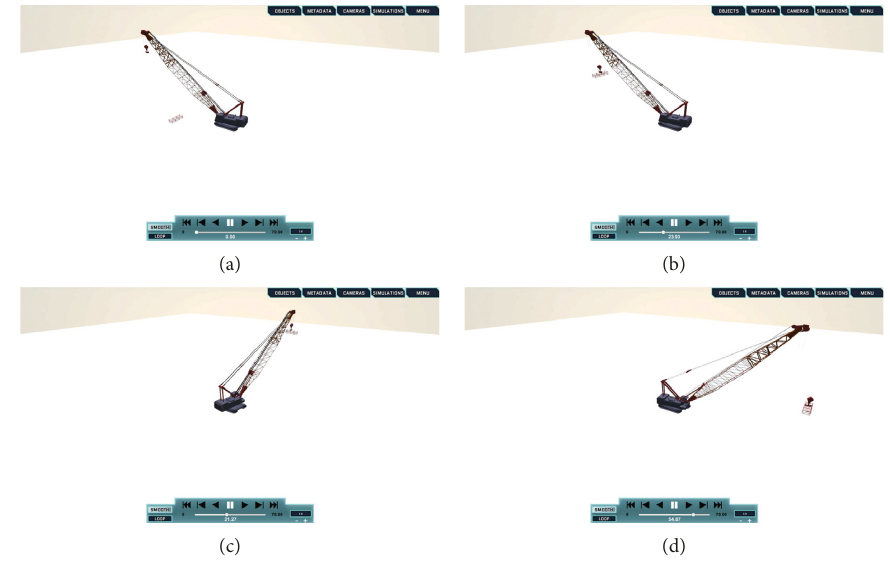
Figure 10: Handling of a module using a crane that shows lifting, swinging, hauling, and